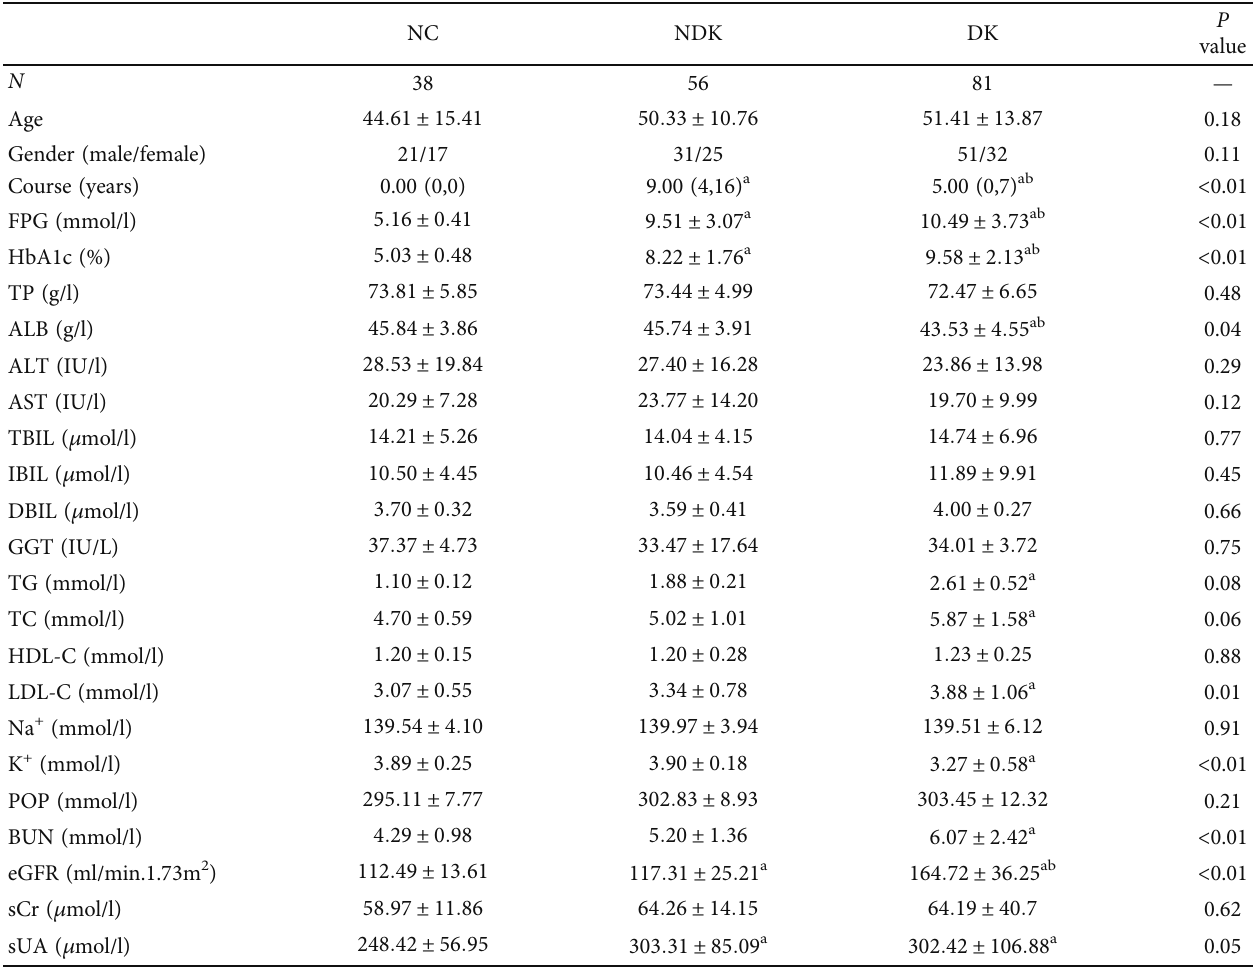
Table 1: General information in DK